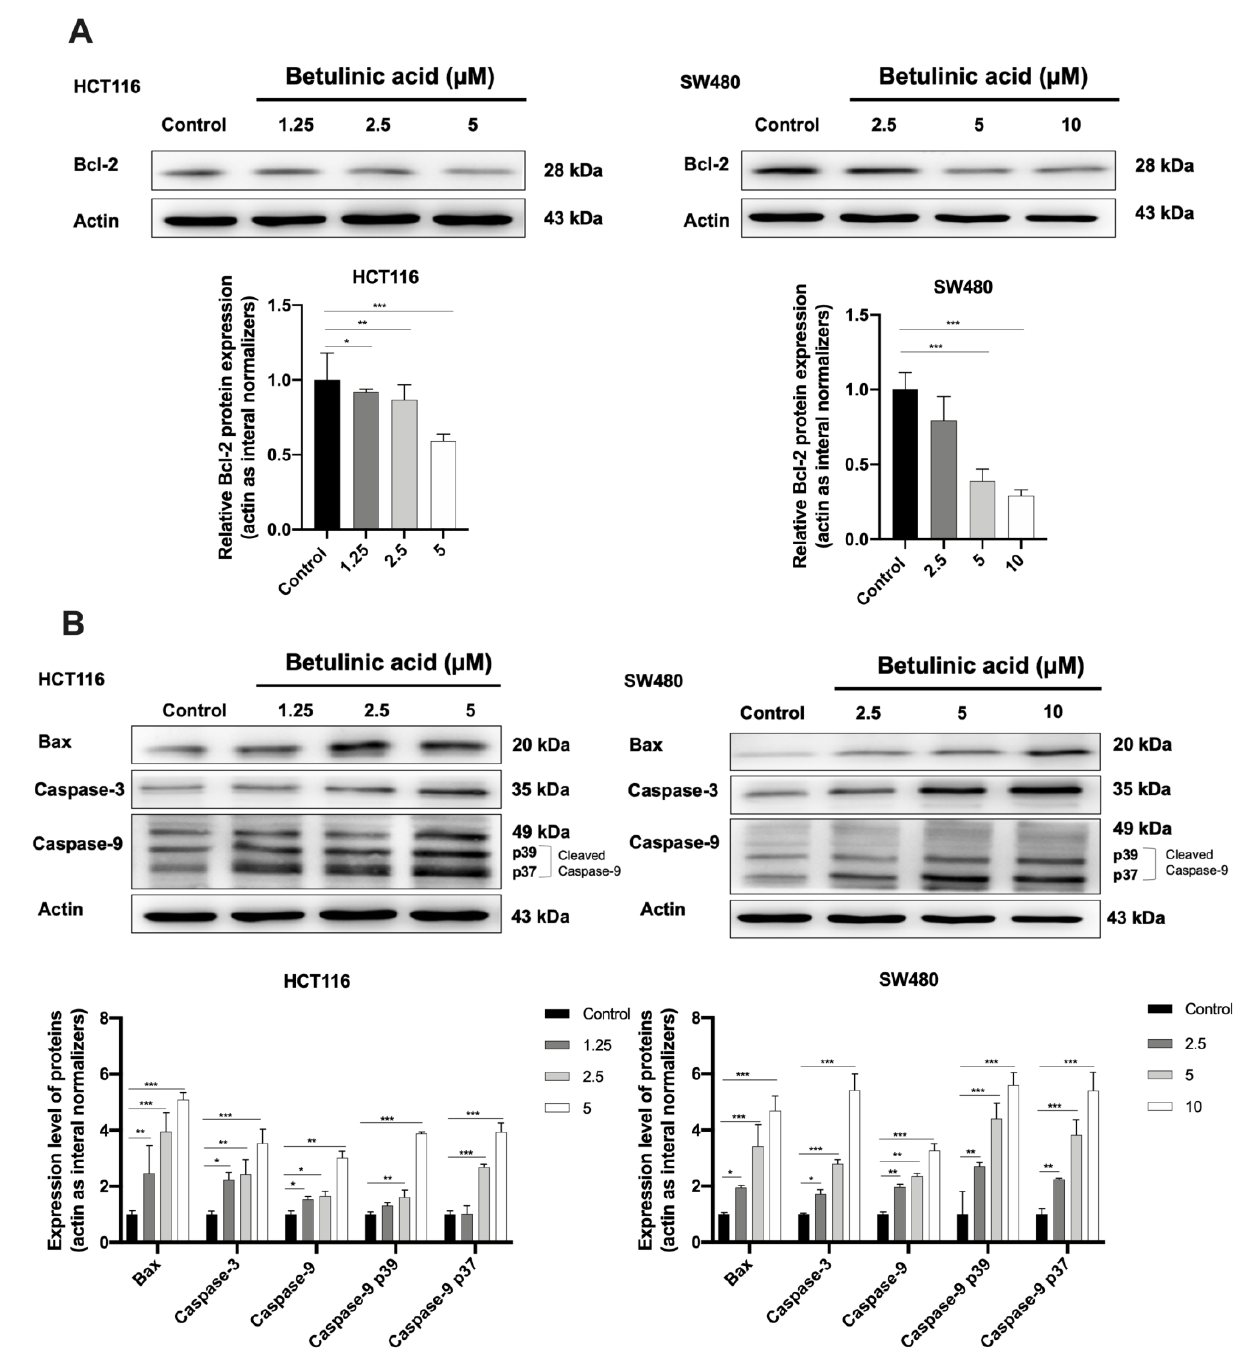
Figure 6. Western blot analysis showing the expression of anti-apoptotic ( A ) and proapoptotic proteins ( B ) in HCT116 and SW480 colorectal cancer cells at 24 h following the BA treatment. Actin was used as the internal control. Experiments were carried out in triplicate. Results are represented as mean ± standard error of the mean (SEM). One-way ANOVA and with Dunnett’s post hoc test were used to test statistical significance with * indicating p < 0.05, ** p < 0.01 and *** p < 0.001 vs. control group.